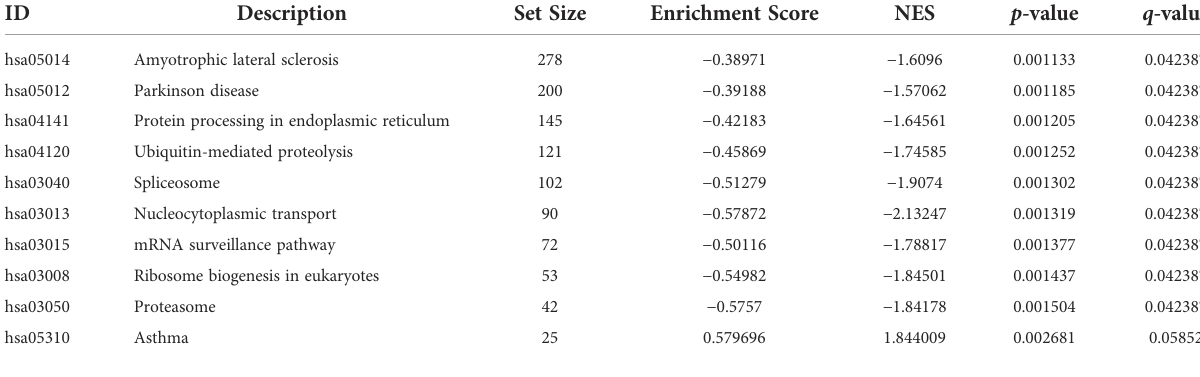
TABLE 2 Top 10 KEGG pathways in OP (|NES| > 1, p -value < 0.05, q -value <